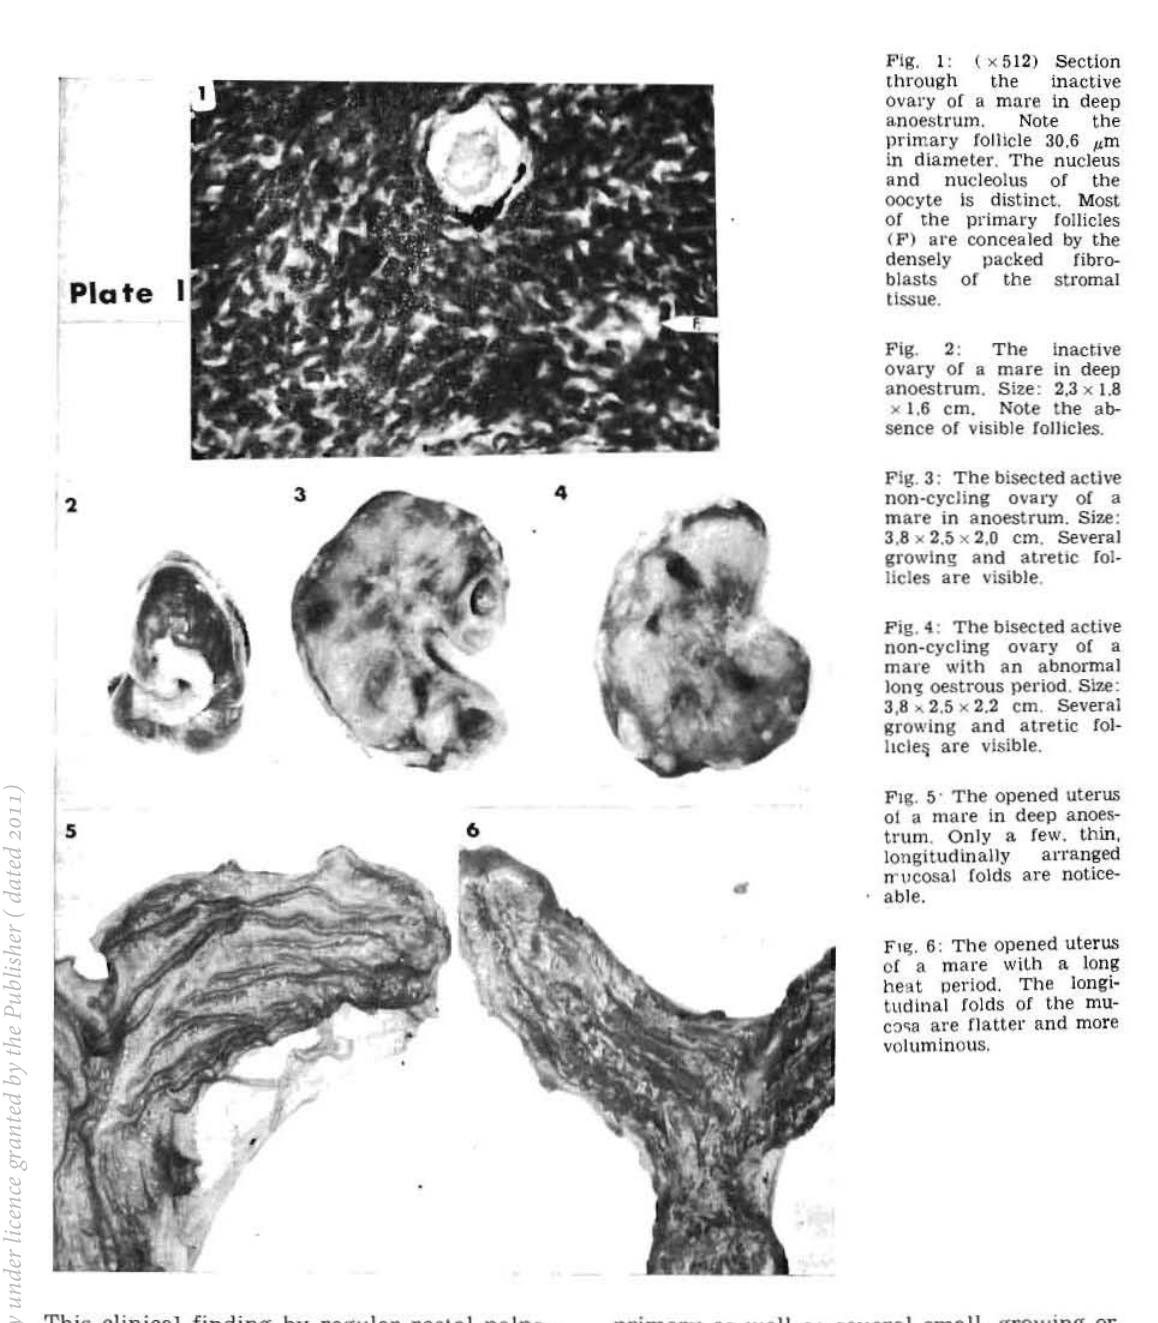
Pig. 1: (" 512) section through the inactive ovary of a mare In deep anoestrum. Note the primary follicle 30,6 I'm in diameter. The nucleus and nucleolus of the oocyte Is distinct. Most of the primal'y follicles IP) aloe concealed by the densely packed fibm blast.5 of the stromal tissue. Fig. 2: The Inactive ovary of a mare in deep anoestrum. Size: 2.3 x 1.8 ,,1.6 em. Note the ab sence of visible folhcles. Pig. 3: The bisected active non-cycling ovary of a mare in anoestrum. Size: 3,8 )( 2.5 x 2,0 em. Several a:rowlng lind atretic fol. IIcles are visible. Fig. ~ : The bisected active non-cycling ovary of a mare with an abnorm91 lon'j oestrous period. S~: 3,8 ,, 2,5)( 2.2 em. SeYeral growing and atretic fol hcle~ are Ylslble. FIg. 5 ' The opened uterus 01 a mlll'e in deep anoes trum. Only a few. thin, longitudinally arranged n' ueosal fOlds are notice able. F''';. 6: The opened uterus of a mare wilh It long heat period. The longi tudinal folds of the mu C:l~~ are flatter ~nd more